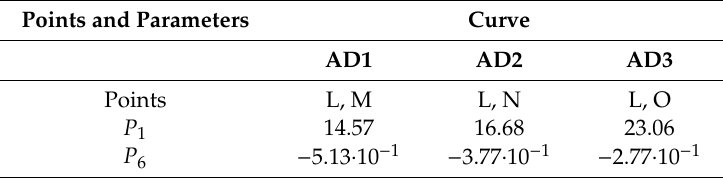
Table 22. P 1 and P 6 for the Alnico decreasing curves.